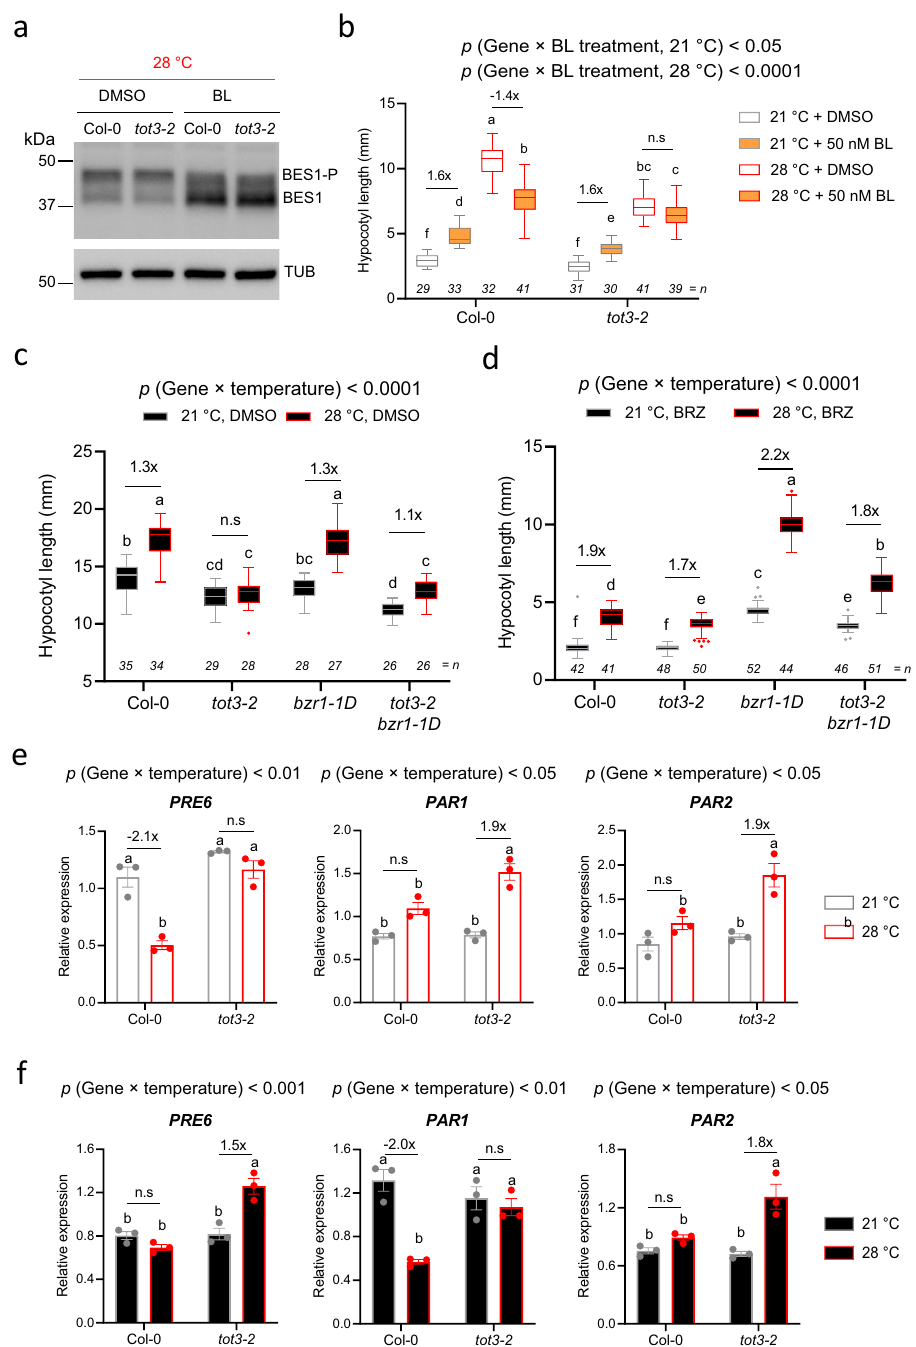
Fig. 6 TOT3 impinges brassinosteroid signalling pathway. a Representative western blot (of 3 biological replicates) of BES1 phosphorylation status in 4-day-old Col-0 and tot3-2 seedlings grown on mock (DMSO) or 100 nM brassinolide (BL) at 28 °C under short-day conditions. BES1 was detected with anti-BES1 antibody. BES1-P, phosphorylated BES1; BES1, dephosphorylated BES1. Detection of TUBULIN (TUB) was used as a loading control. b Hypocotyl length of 5-day old tot3-2 and Col-0 wild-type plants grown at 21 and 28 °C in short-day conditions on medium containing DMSO or 50 nM brassinolide. c , d Hypocotyl length of 4-day old tot3-2 , bzr1-1D , tot3-2 bzr1-1D and Col-0 wild-type seedlings grown at 21 and 28 °C in darkness on MS/2 medium containing DMSO ( c ) or 1 µ M brassinazole ( d ). e Relative expression of BZR1 target genes PRE6 , PAR1 and PAR2 in Col-0 and tot3-2 plants grown at control (21 °C) and warm temperature (28 °C) under short-day conditions. f Relative expression of BZR1 target genes PRE6 , PAR1 and PAR2 in Col-0 wild-type and tot3-2 plants grown at control (21 °C) and warm temperature (28 °C) under dark conditions. Box plots show median with Tukey-based whiskers and outliers ( b , c , d ). The number of individually measured seedlings ( n ) is indicated above the X -axis ( b , c , d ). Bar diagram shows mean of 3 biological replicates (individual dots) with standard error of the mean ( e , f ). Letters indicate signi fi cant differences based on two-way ANOVA and Tukey ’ s test ( p < 0.01); n.s: not signi fi cant. The p -value for the interaction (genotype × temperature or genotype × treatment) is shown at the